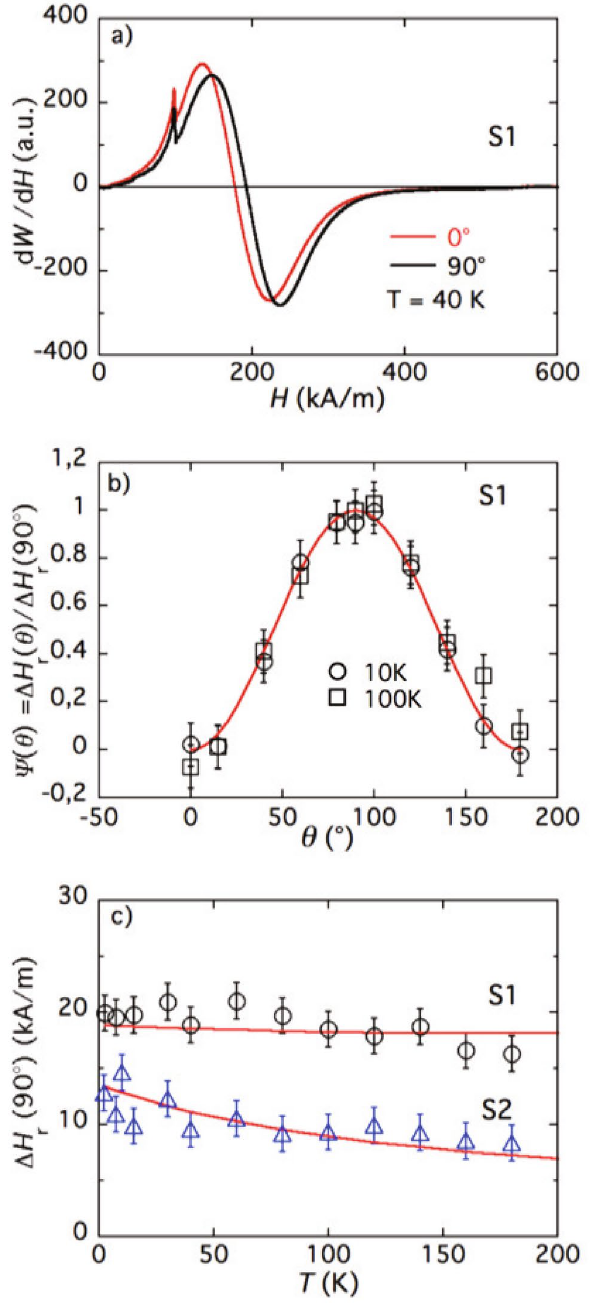
Figure 2. ( a ) Typical FMR spectra of sample S1. As in Ref. 27 , the first small peak at ∼ 100 kA/m is due to residual impurities in the glass micropipe containing the ferrofluid sample. ( b ) Angular dependence of the resonance field for textured sample S1 at T = 10 and 100 K; full line is ( 1 − cos � H r ( 90 ◦ ) of the FMR field as a function of temperature for samples S1 and S2; full lines are calculated using Eq.